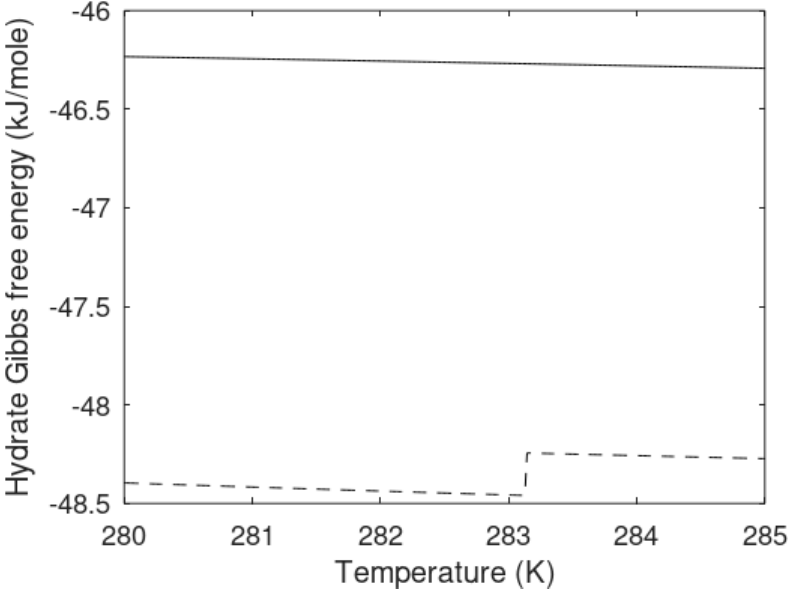
Figure 26. Gibbs free energy for heterogeneous hydrates of CH 4 (solid) and CO 2 (dashed) along hydrate stability limits in Figure